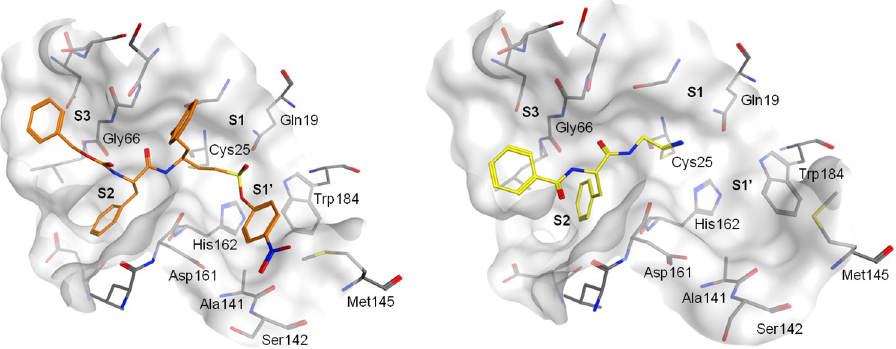
Fig 3. Crystal structures of vinyl sulfone derivative K777 and dipeptidyl nitrile 33L covalently bound to cruzain. Left. K777 in the active site of cruzain (PDB-ID: 1F2B). Right 33L in the active site of cruzain (PDB-ID 4QH6).